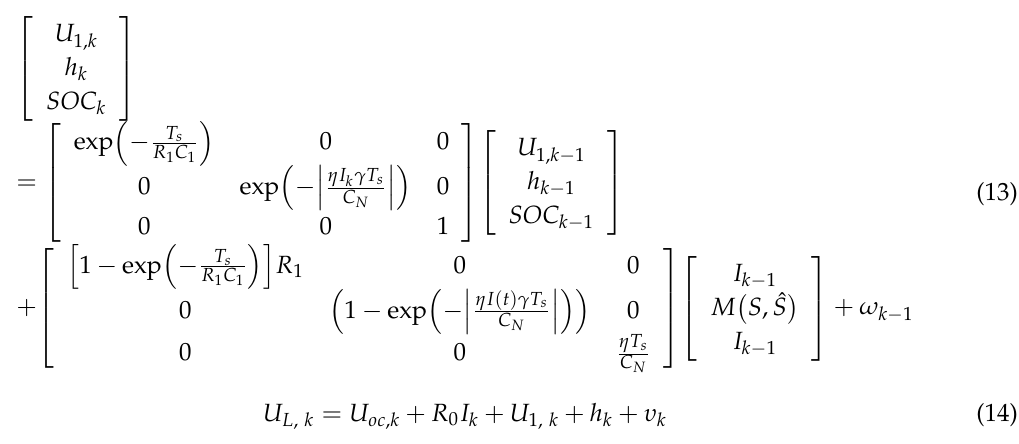
Figure 9. The mean absolute error (MAE) and root mean squared error (RMSE) of the original model and improved model.